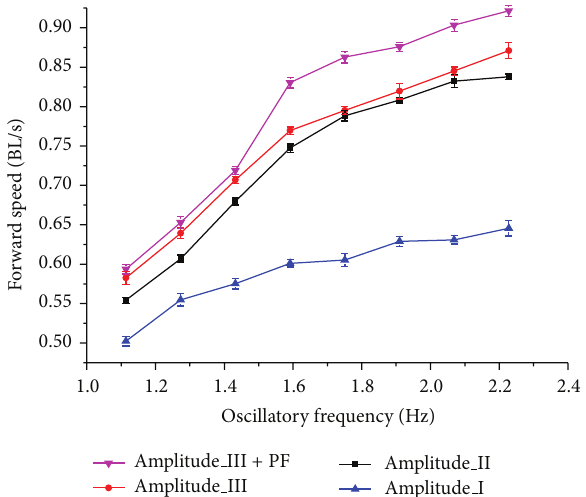
Figure 13: Speed test of the PF swimming by changing the oscil- latory